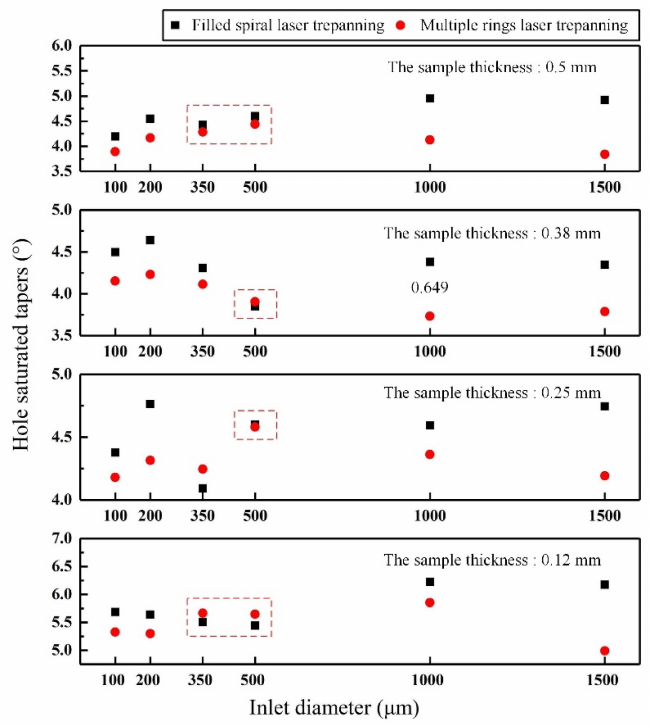
Figure 6. Saturated hole tapers ablated in Al 2 O 3 ceramics of various